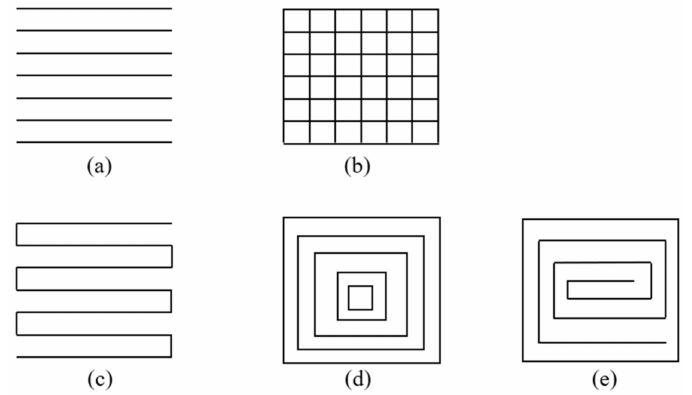
Figure 1. ( a ) Raster path; ( b ) grid path; ( c ) zigzag path; ( d ) contour o ff set path; ( e ) spiral